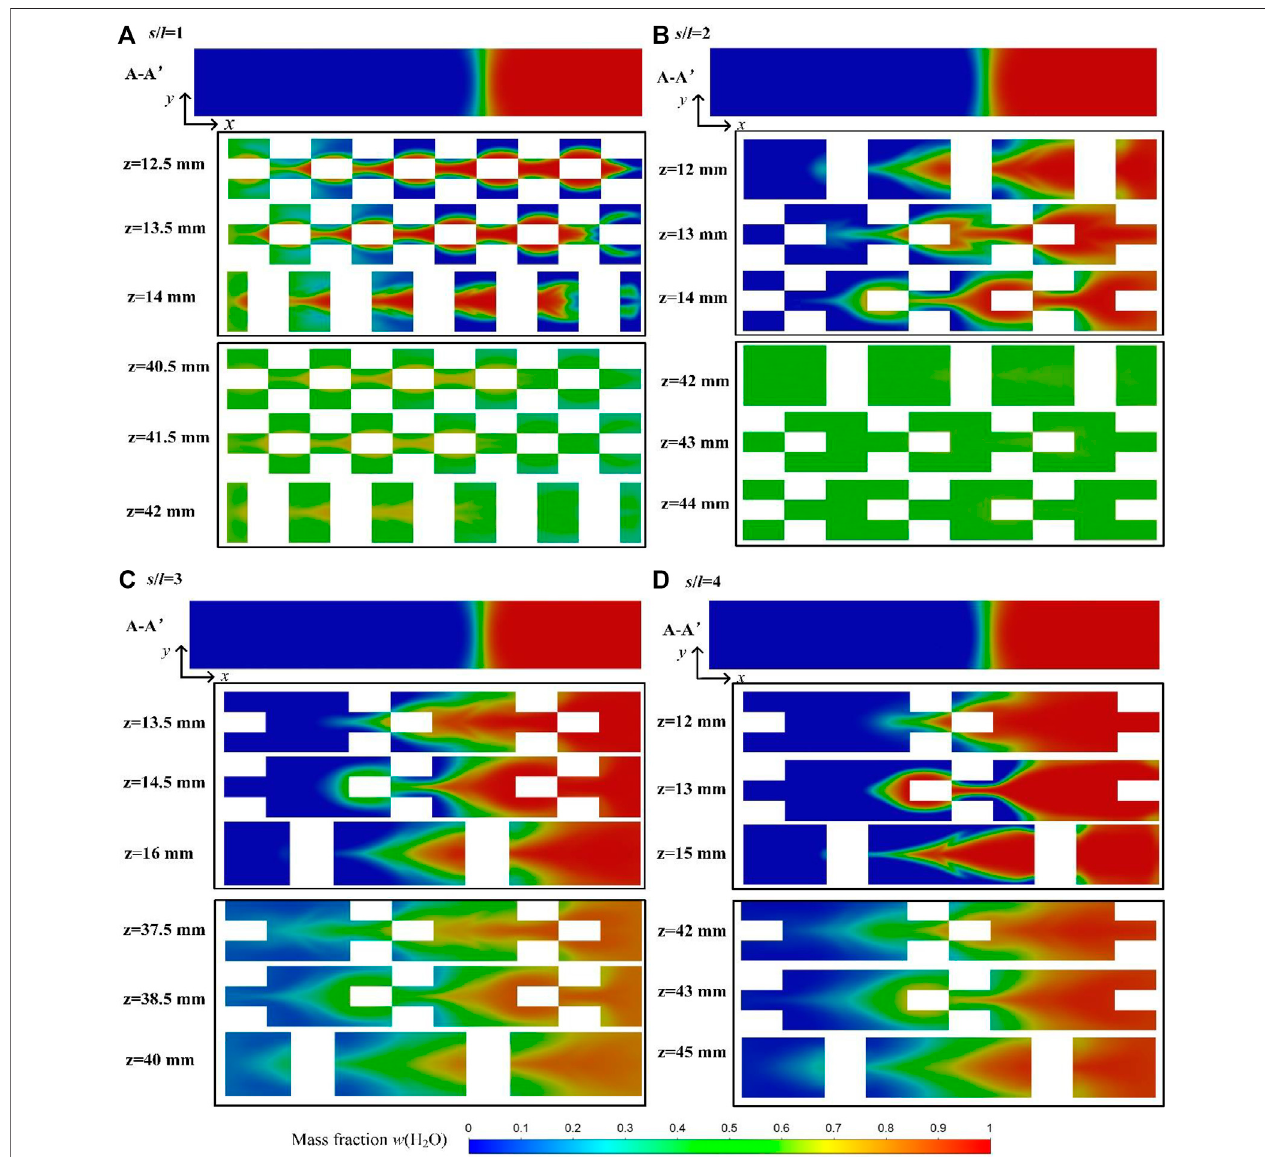
FIGURE12| Concentrationdistributionofwateron x-y planeswithdifferentratiosof s / l at R e (cid:1) 0.2( V / H (cid:1) 10:10, V (cid:1) 10 mm, l (cid:1) 1 mm): (A) s / l (cid:1) 1, (B) s / l (cid:1) 2, (C) s / l (cid:1) 3, and (D) s / l (cid:1) 4.